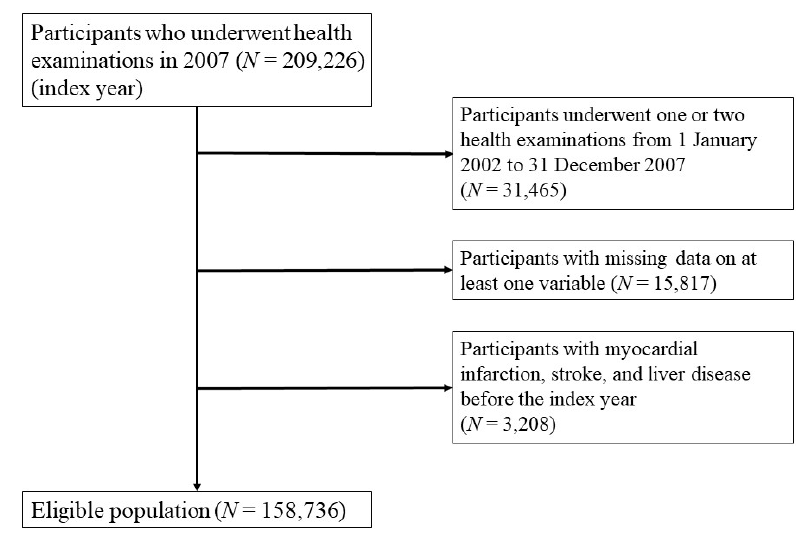
Figure 1. Flow chart of the study population.